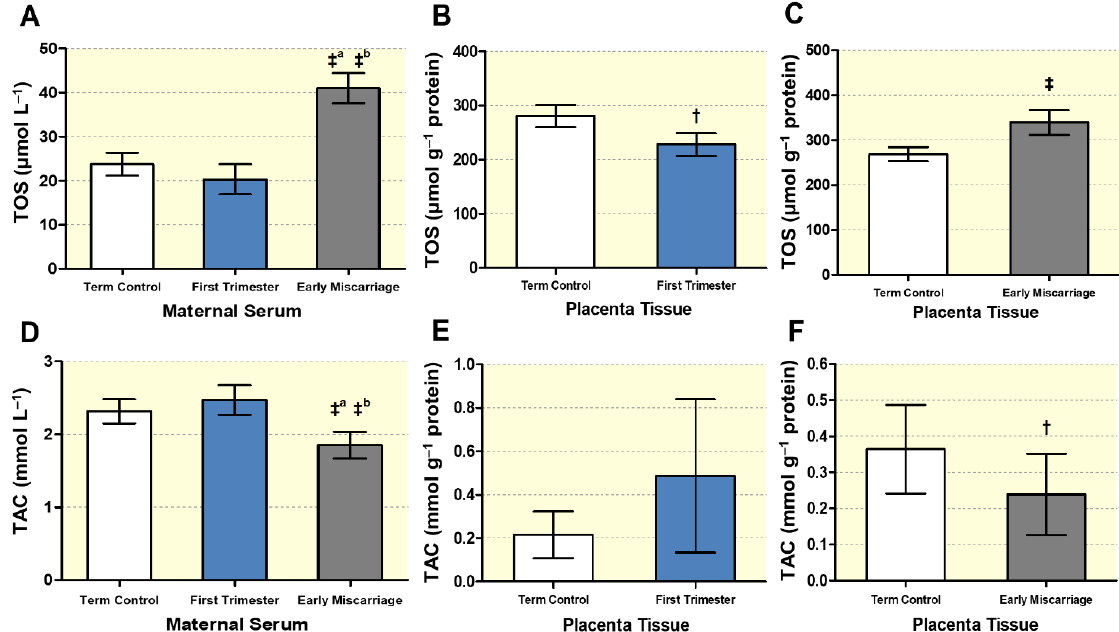
Figure 5. Determination of total oxidative stress (TOS) and total antioxidant capacity (TAC). TOS was determined in ( A ) maternal serum of first trimester, EMC patients, and term controls ( n = 20, n = 20, and n = 19, respectively), ( B ) placentae of first trimester and term controls (n = 6 and n = 5, respectively; Swiss cohort), and ( C ) placentae of EMC and term controls (n = 20 and n = 19, respectively). Analysis of total antioxidant capacity (TAC) in ( D ) maternal serum of first trimester, EMC patients, and term control ( n = 20, n = 20, and n = 19, respectively), ( E ) placentae of first trimester and term controls ( n = 6 and n = 5, respectively; Swiss cohort), and ( F ) placentae of EMC and term control ( n = 20 and n = 19, respectively). Data are shown as mean ± SD for each group. In ( A , D ), statistical analysis was performed by using Kruskal – Wallis test followed by Dunn ’ s multiple comparison test. In ( B , E ) and ( C , F ), statistical evaluation was performed by using two-tailed Mann – Whitney test for comparing first trimester vs. term controls (Swiss cohort) and EMC vs. term controls, respectively. ‡ ( p ≤ 0.001), † ( p ≤ 0.01). ‡ a : significance between EMC and term control; ‡ b : significance between EMC and 1st trimester.